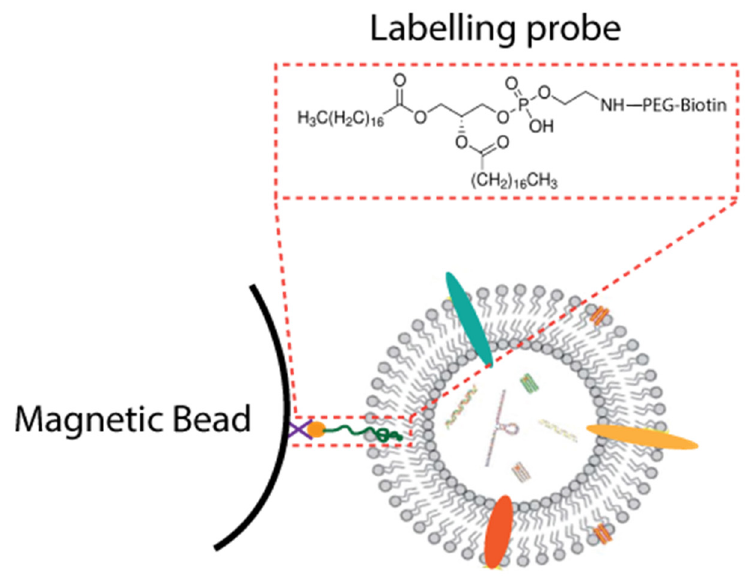
Figure 3. Structure of the lipid nanoprobe.